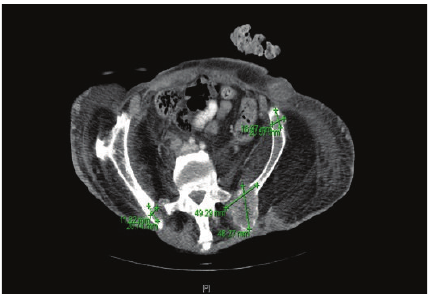
Figure 2: Computed tomography (CT) scan of the abdomen and pelvis demonstrated soft tissue masses with bony destruction of the iliac spines (green lines demarcate bony metastases).